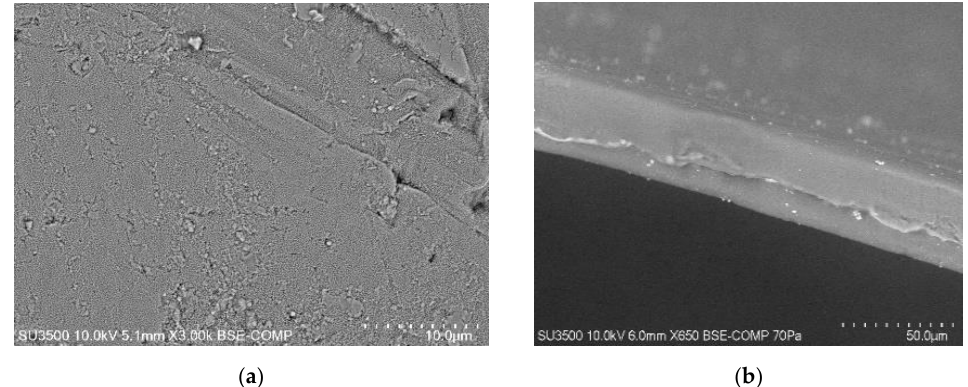
Figure 2. SEM picture of PIMs doped with ethylenediamine-bis-acetylacetone as: Front view ( a ), side view ( b ).